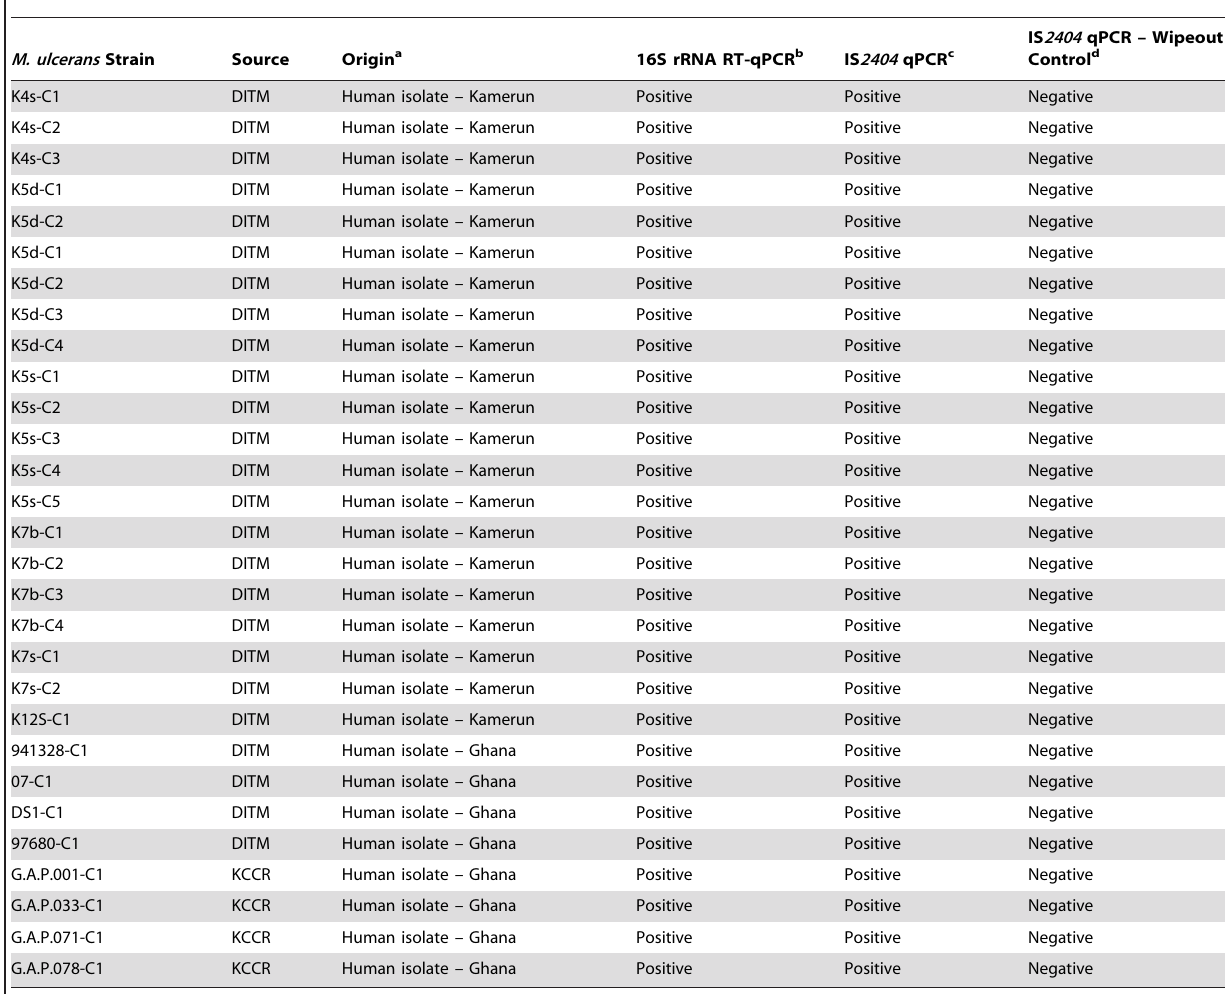
Table 1 shows 29 M. ulcerans cultures that were available at the Department of Infectious Diseases and Tropical Medicine (DITM) and the Kumasi Centre for Collaborative Research (KCCR) for development and technical validation of the 16S rRNA RT/IS 2404 qPCR viability assay and the corresponding test results. Sequence analysis of 16S rRNA genes from the listed strains revealed 100% nucleotide concordance of the corresponding genomic regions amplified by the 16S rRNA RT-qPCR; no SNPs or mutations were detected, suggesting a high selectivity of the assay. Sequencing primers are described in Table 3 [11]. a M. ulcerans cultures were available from previous studies from Kamerun ( n =21) and Ghana ( n =4) at DITM [8] or were available at KCCR ( n =4) from the present study. All strains were of human origin (BUD patients) and confirmed by conventional IS 2404 PCR and sequencing of rpoB - and rpsL -genes that revealed the M. ulcerans Agy99